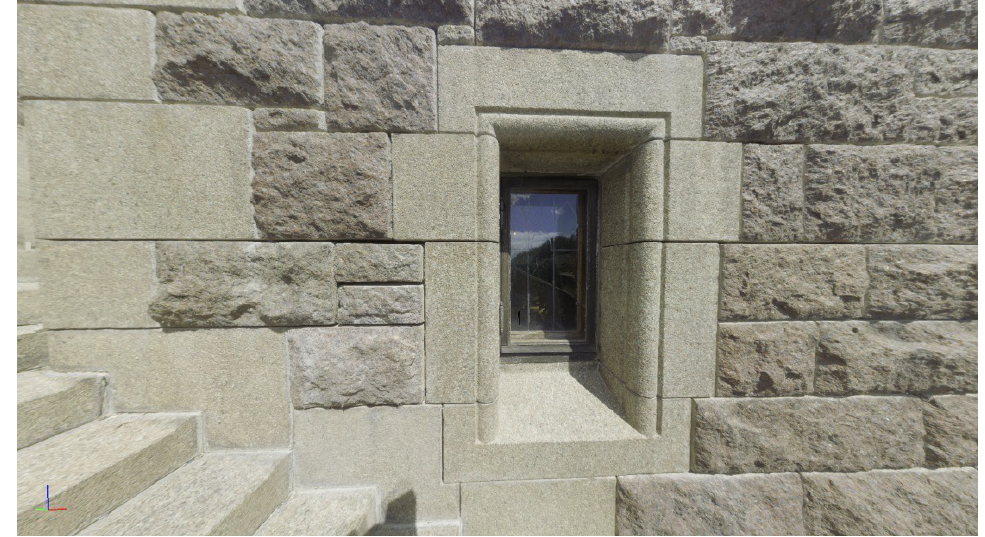
Figure 3. Default view from the panoramic image directly facing the area of interest